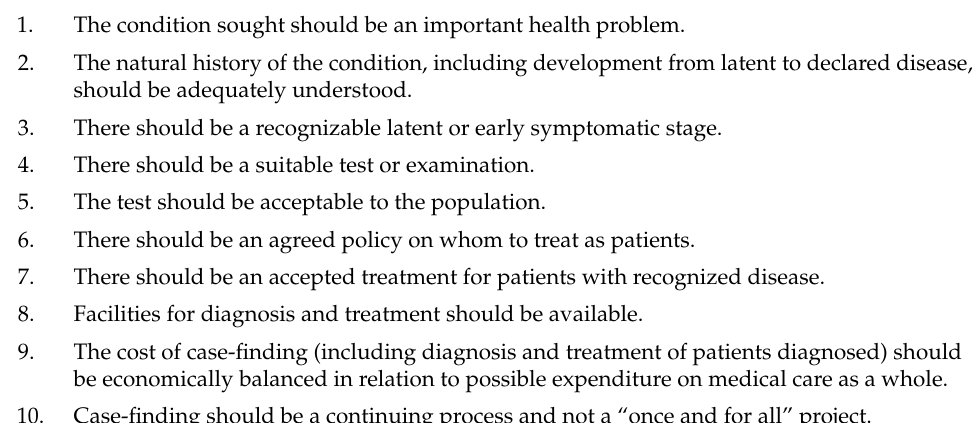
Table 1. Wilson and Jungner’s principles of screening